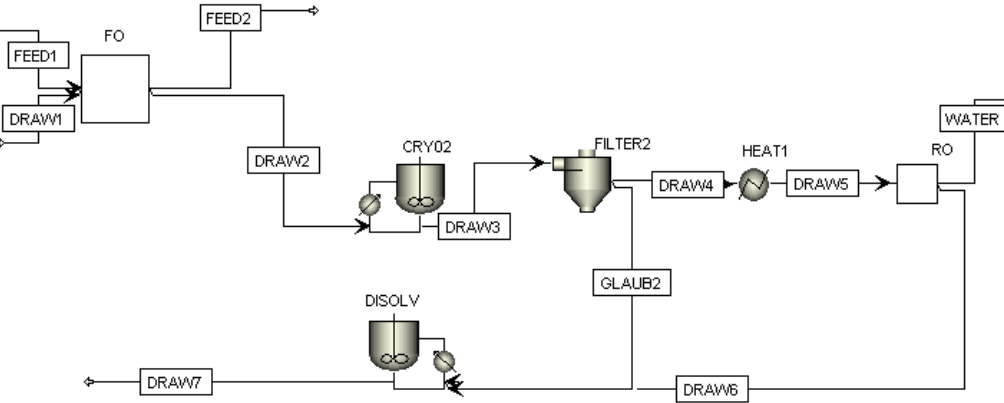
Figure 2. Aspen Plus flowsheet of the FO process using Na 2 SO 4 as the draw solute.